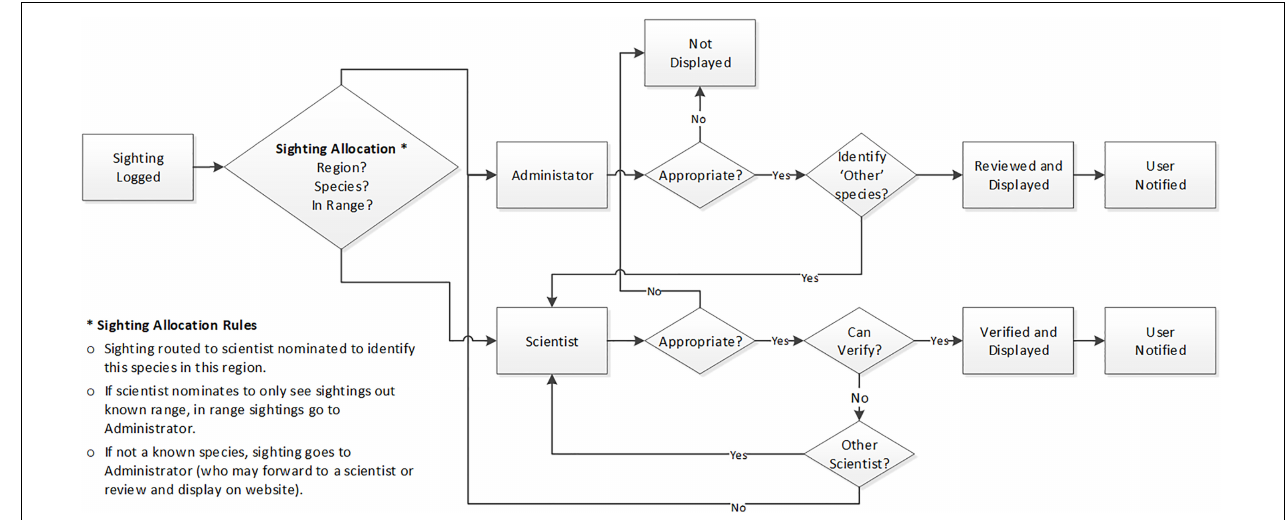
FIGURE 3 | Overview of the management workflow for observations submitted for the Redmap website and database verification system, including feedback provided to the contributor, and the flexible ‘sighting allocation’ process that is key to the semi-automated observation verification